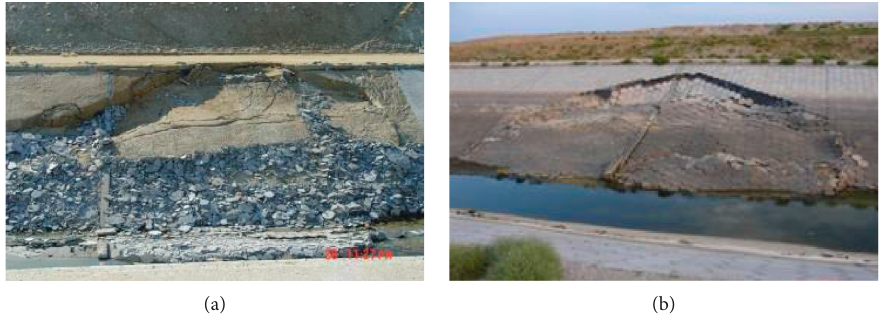
Figure 1: Typical slope failure of main canal in Xinjiang,